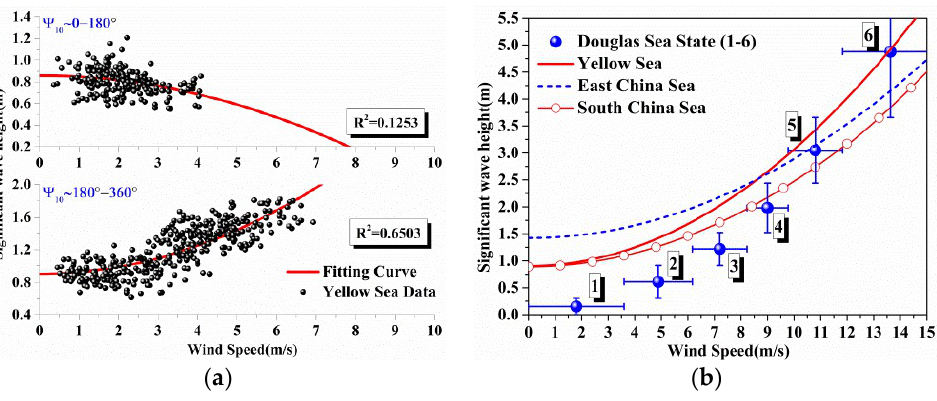
Figure 4. ( a ) The comparison between the scattered data (data points) based on wind direction and empirical formulas (line) versus wind speeds at above 10 m sea surface in the Yellow Sea. ( b ) Detailed comparison between empirical formulas in different seas and the Douglas Sea State, and the sea state levels from 1 to 6 are shown in the Figure 4b.